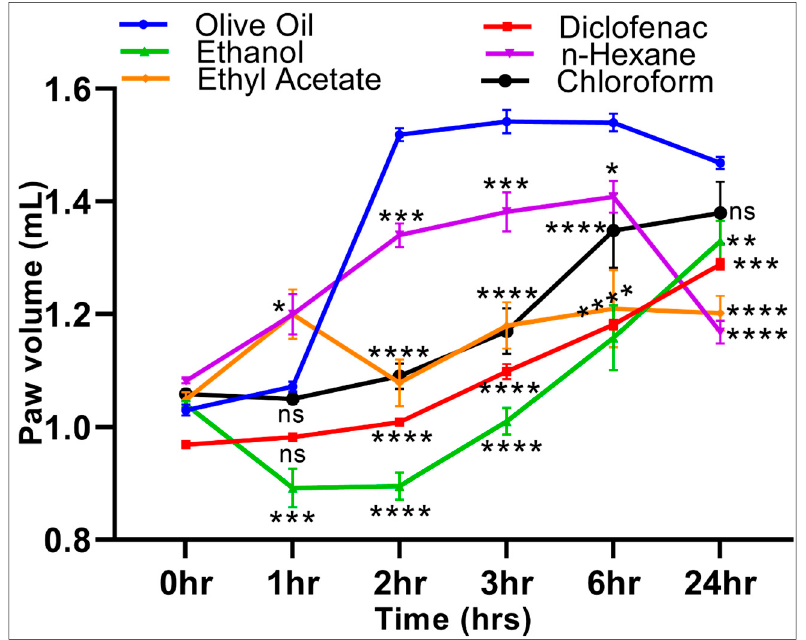
Figure 3. Anti-inflammatory activities of S. cyclophylla extracts assessed via carrageenan-induced paw edema in rats. The values denoted are mean ± SEM, n = 6 animals/group. The statistical significance were performed via a one-way ANOVA followed by a posthoc test using Tukey’s multi- group comparison: ns: not significant, * p < 0.05, ** p < 0.01, *** p < 0.001, and **** p < 0.0001 compared to the olive oil group. For example, at 2 h compared to the olive oil control group, the diclofenac, aqueous-ethanolic, ethyl acetate, and chloroform groups were significantly different, * p < 0.0001.